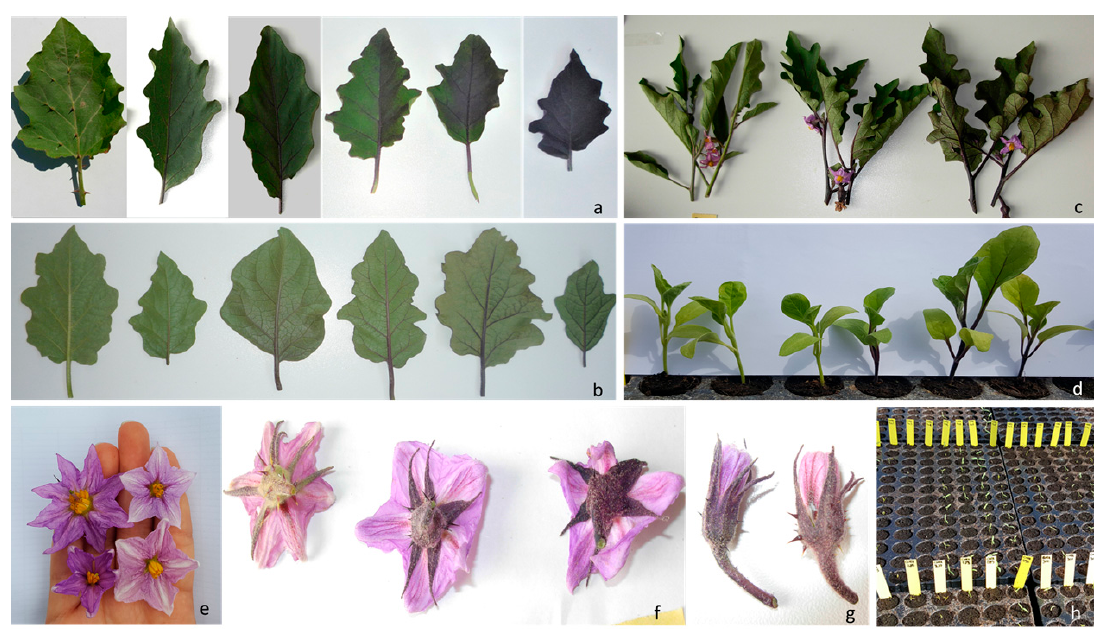
Figure 1. Phenotypic trait evaluation. ( a ) adlan (range from 0 to 5); ( b ) lvean (0–5); ( c ) stean (1,3,5); ( d ) hyan (0, 5); ( e ) corcol (clockwise from top-right: light violet, light pink, dark pink, dark violet); ( f ) flian (1,3,5); ( g ) toan (violet-reddish); ( h ) sei (picture at 10 days after sowing).